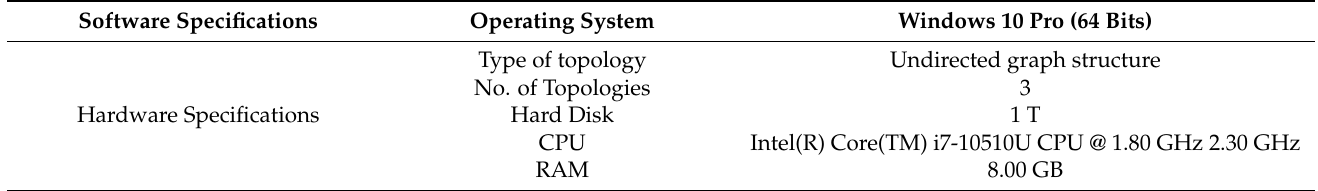
Table 5. Original system configuration and input parameters using the SA-MCSDN algorithm.